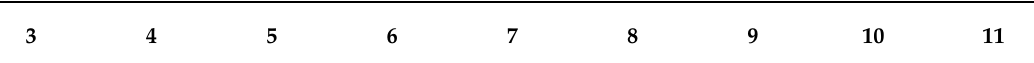
Table 1. Descriptive statistics, ICC values, and Pearson’s